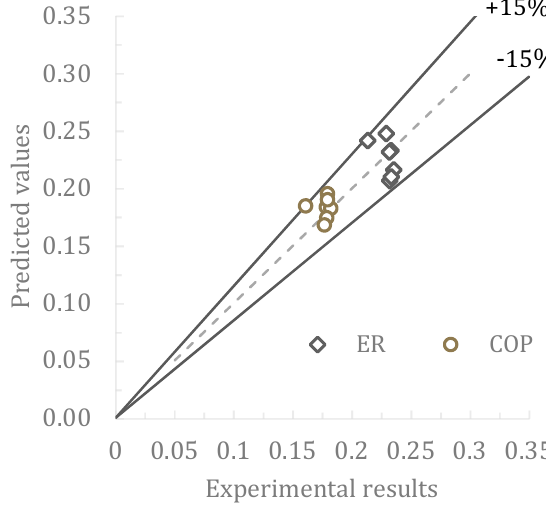
Figure 5. Validation of mathematical model by experimental results.